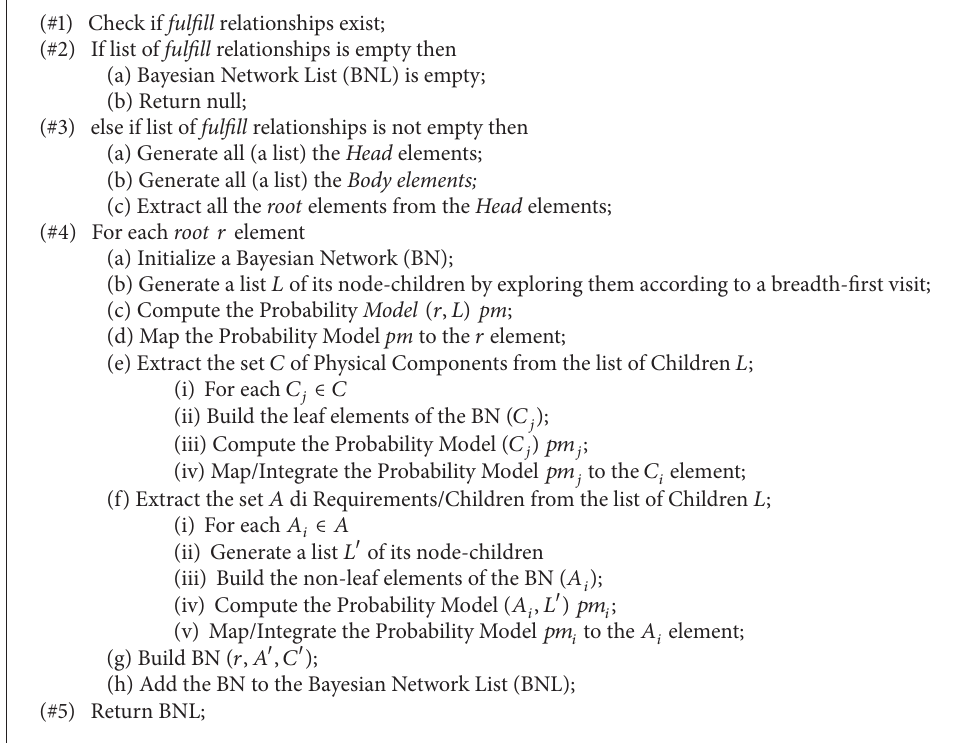
Algorithm 1: Pseudo-code for generating Bayesian Networks from Modelica-based